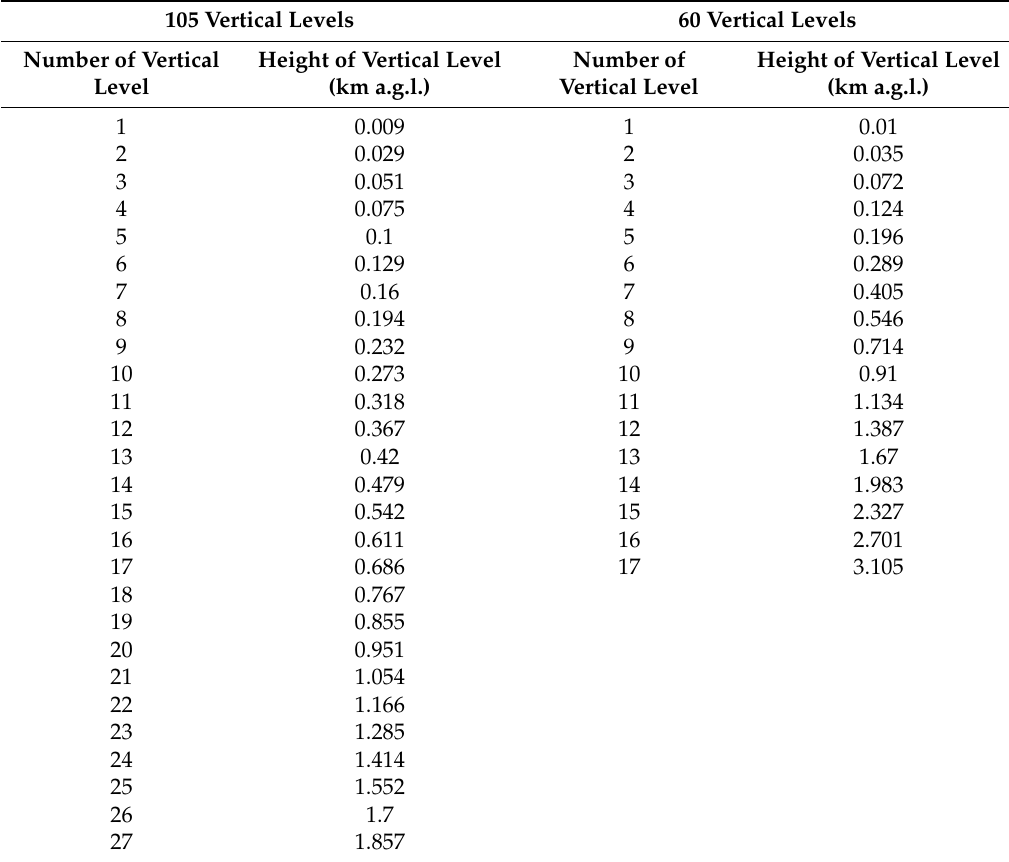
Table A1. Height of lowest model levels up to 3 km altitude for 60 and 105 vertical levels used in